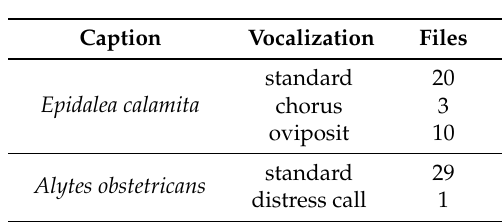
Table 1. Analysis of the sound